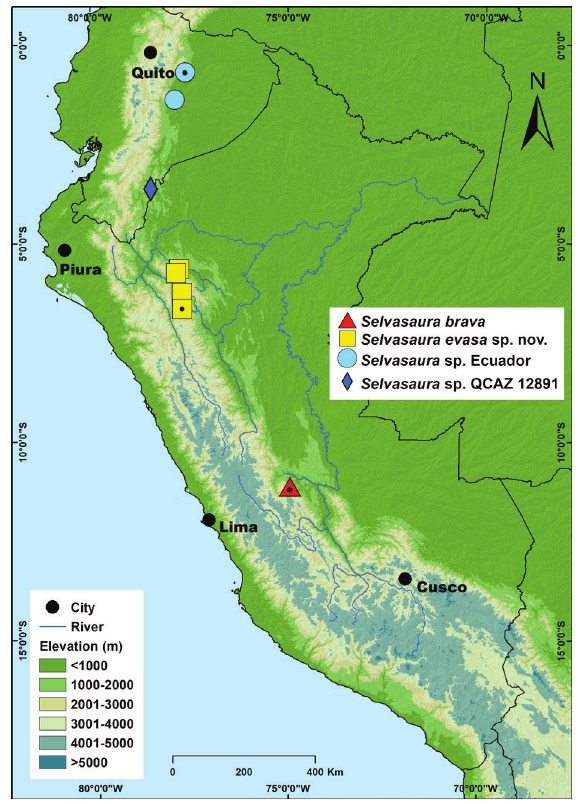
Figure 5. Distribution map of Selvasaura . Symbols with a dot in the middle correspond to type